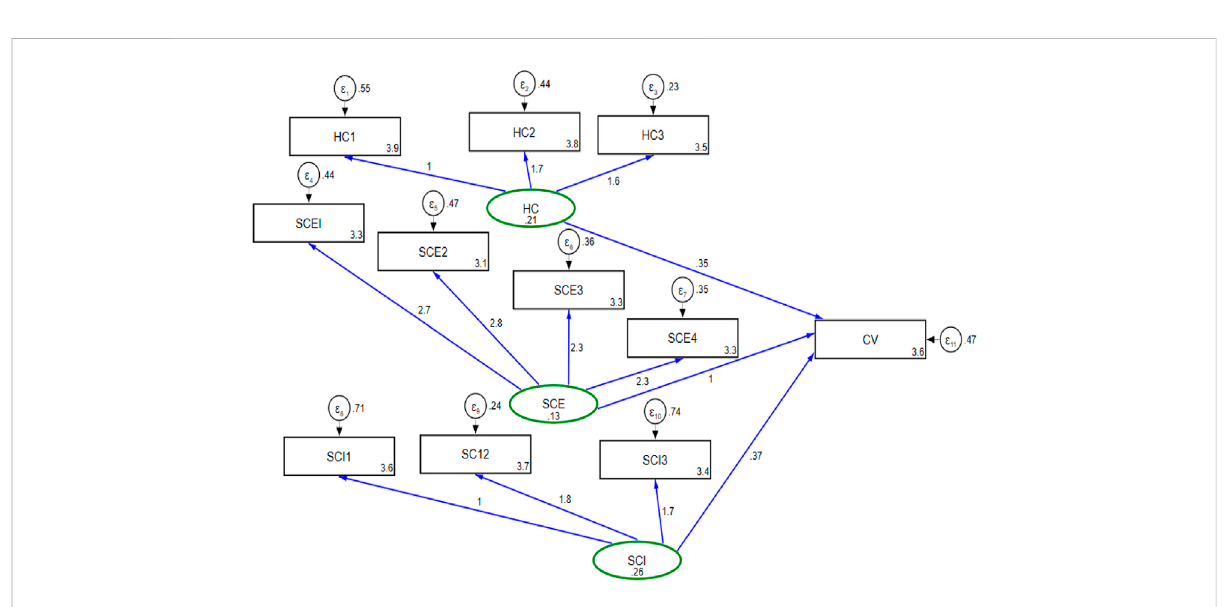
FIGURE 5 Direct Measurement